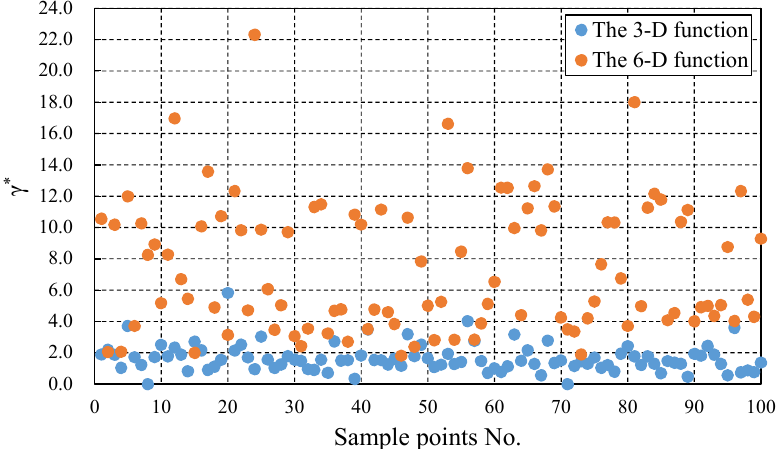
Figure 7. The γ ∗ at different sample points of the two test functions in the case of ALMESM with 100 sample points.